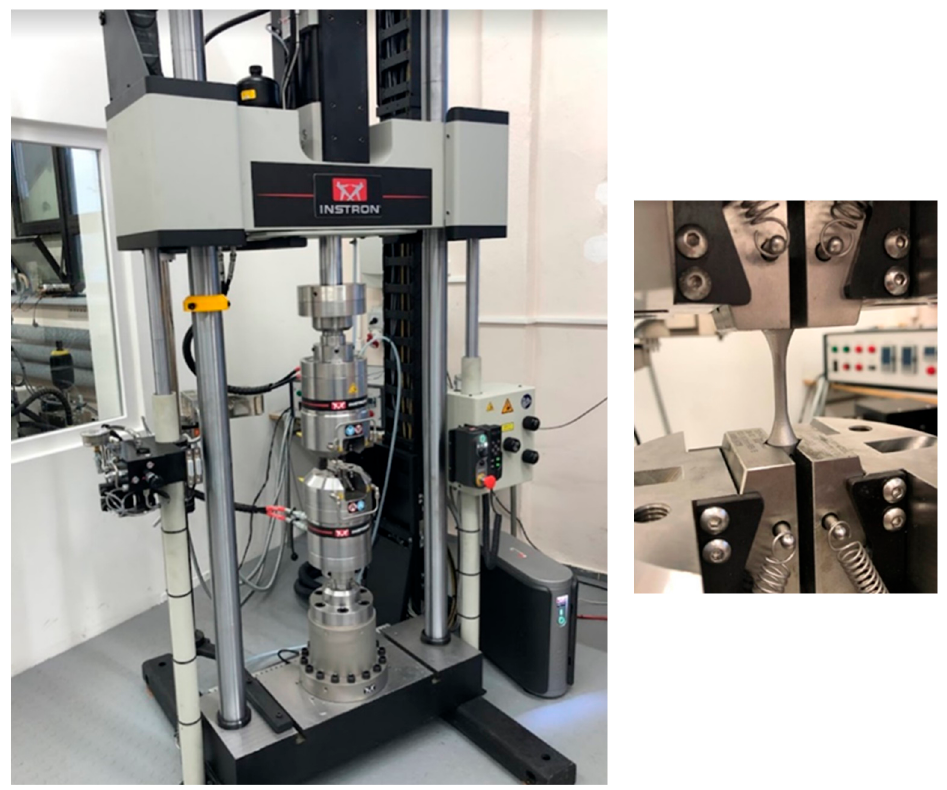
Figure 3. Fatigue test stand for tension–compression axial loading, Instron 8852, at Opole University of Technology.